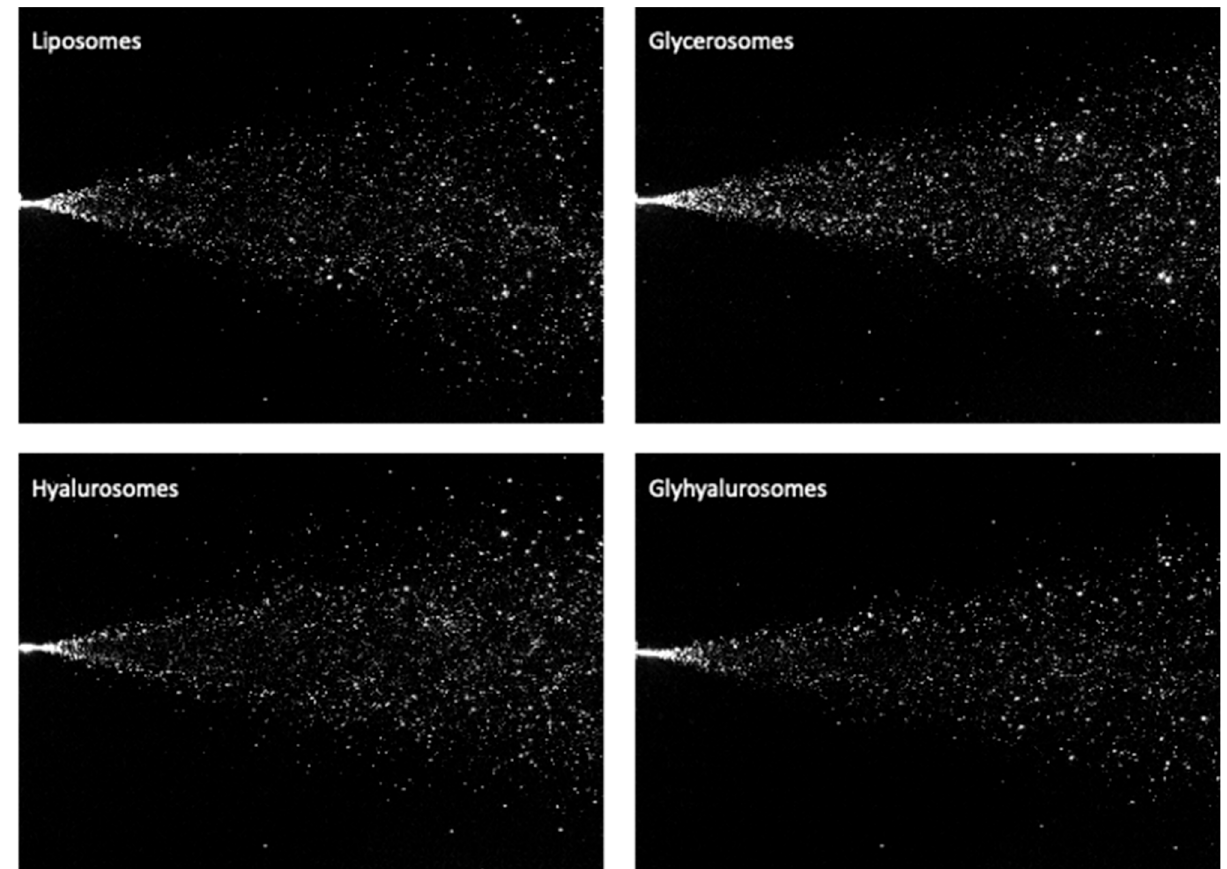
Figure 5. Representative images of instant visualization of sprays generated by liposomes, glycerosomes, hyalurosomes and glyhyalurosomes.